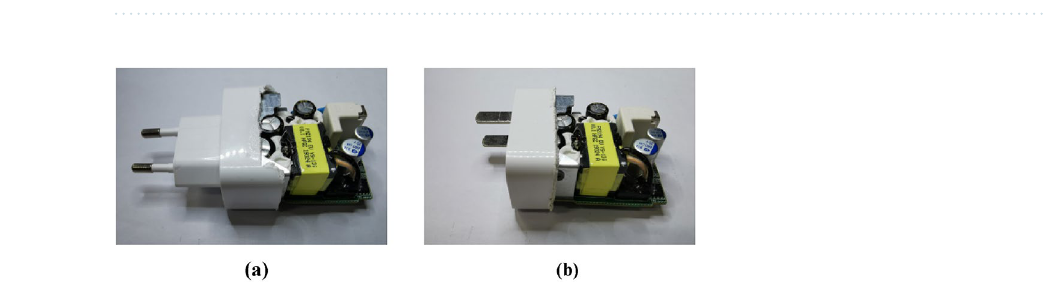
Figure 29. Front and component layout of the prototype.